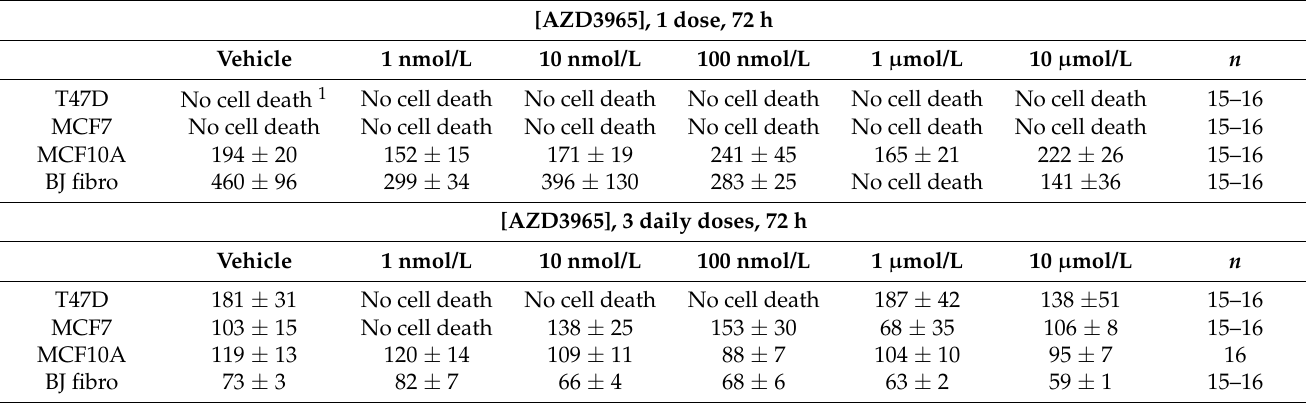
Figure 3. Lactate as an oxidative fuel ensures the survival of malignant but not of nonmalignant breast-associated cells, with no cytotoxic effect of AZD3965. ( A , B ) T47D, MCF7, MCF10A cells and BJ fibroblast density was assayed in medium containing 10 mmol/L sodium L -lactate, no glucose, no glutamine and 1% FBS. ( A ) Cell density over time after a single treatment at time 0 (arrow) with vehicle or different doses of AZD3965 ( n = 8–16). ( B ) Cell density over time upon daily treatments (arrows) with vehicle or a given dose of AZD3965 ( n = 15–16). All data are shown as means ± SEM. Analysis of cell death is presented in Table 1. Table 1. Time (h) to reach 50% cell death in medium containing 10 mmol/L of sodium L -lactate, no glucose, no glutamine and 1% FBS ± AZD3965.